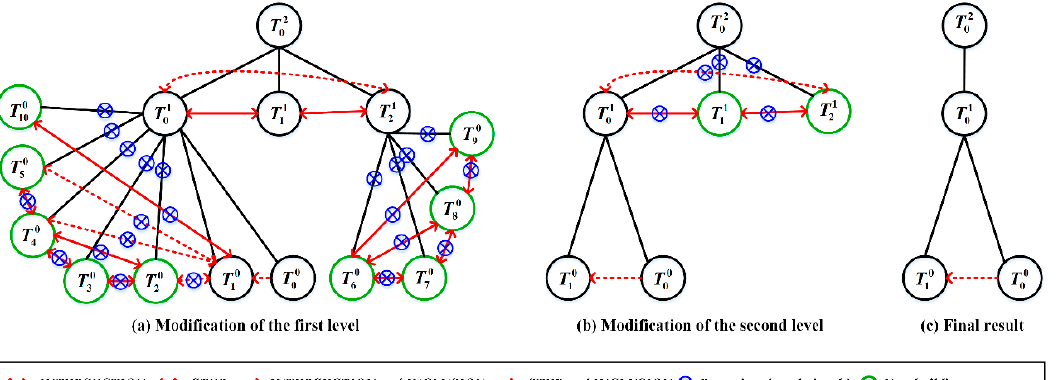
Figure 8. Modifying one TRG (i.e., Figure 7e) from the finest level to the coarsest level after building point detection. If all points in the segment are classified as non-building, the segment node and its relationships are removed from the TRG.